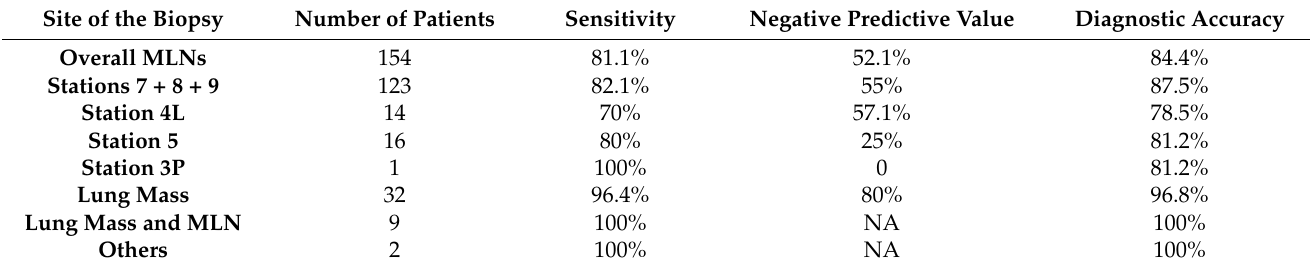
Table 2. Diagnostic yield according to the site of EUS-FNA biopsy .